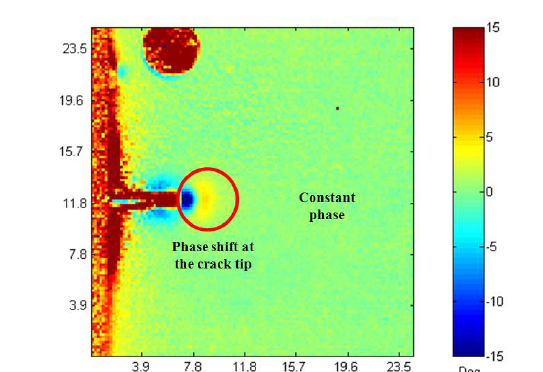
Figure 2: Typical phase map for a 6mm fatigue crack. Illustration of the phase shift occurring at the crack tip as a result of the loss of adiabatic conditions (dimensions in